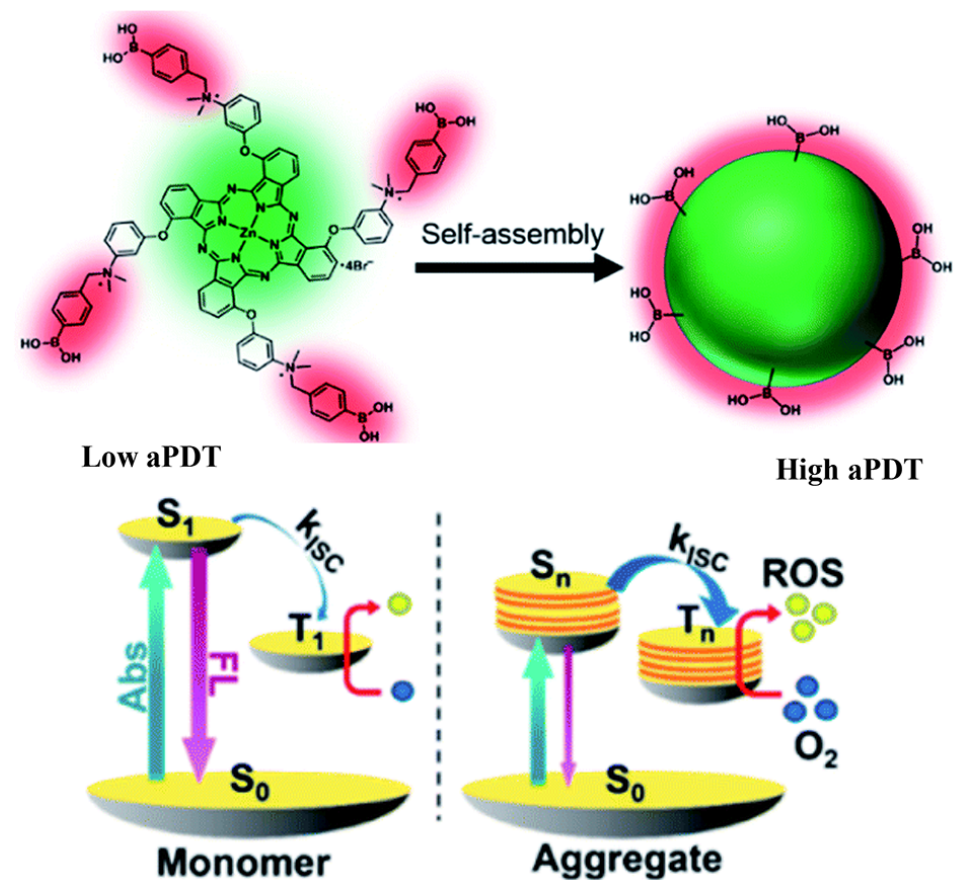
Figure 9. Aggregation-enhanced ROS production of PcN4-BA for combating antibiotic-resistant bacteria. Reprinted with permission from Ref. [91]. Copyright 2020 Royal Society of Chemistry.